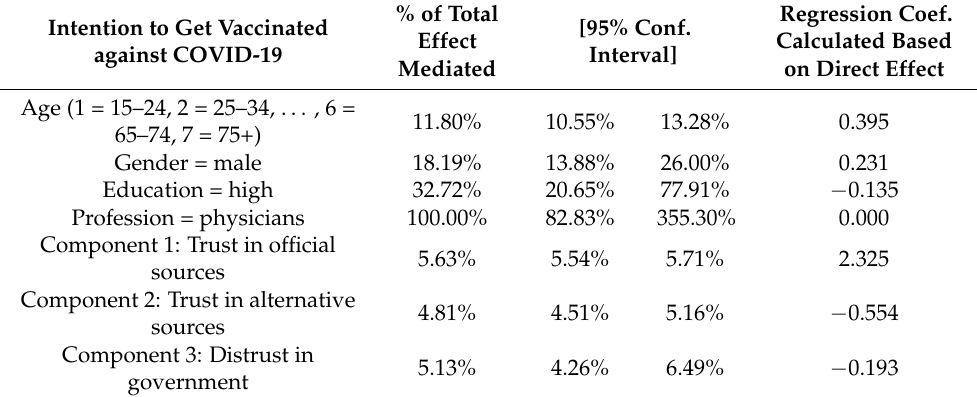
Table 4. Results of mediation